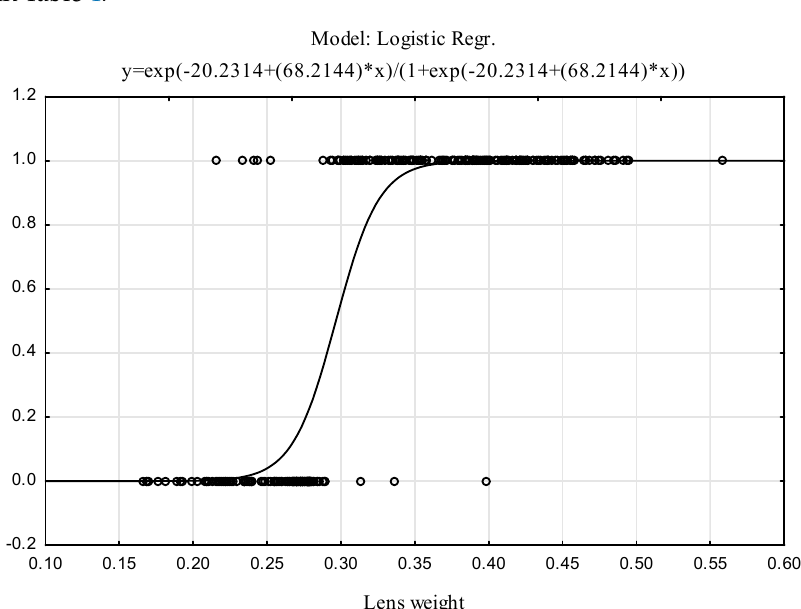
Table 4. Parameter evaluation in the logistic regression model in relation to dry lens weight .